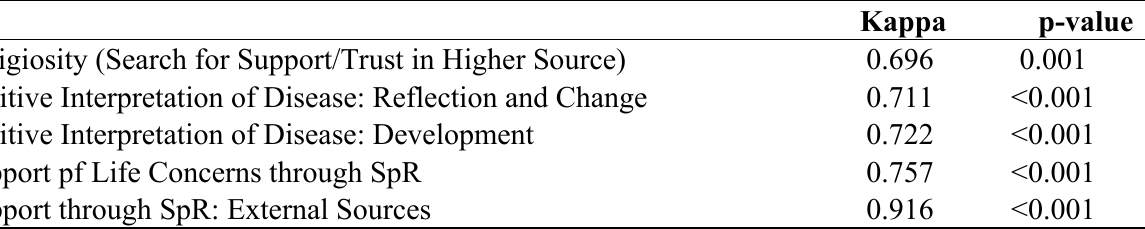
Table 2. The inter reliability agreement test-retest of the SpREUK-Hebrew questionnaire by Kappa.